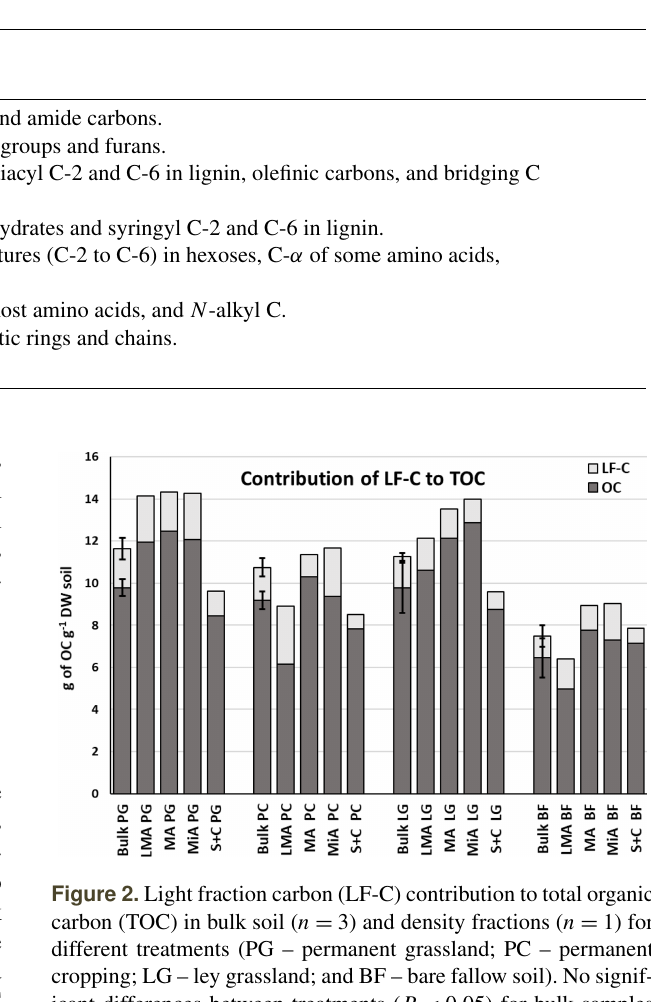
Table 1. Typical assignments for peaks in 13 C NMR solid-state spectra from geochemical samples (Knicker, 2011; Knicker and Lüdemann, 1995). Reference used: Tetramethylsilane = 0parts per million – ppm.